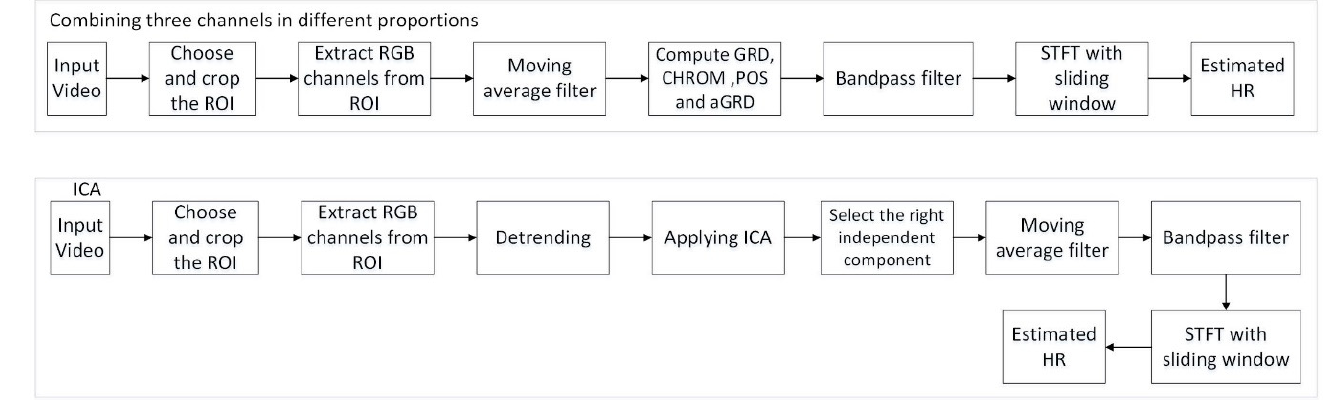
Figure 3. The workflow of combining three channels and independent component analysis (ICA).